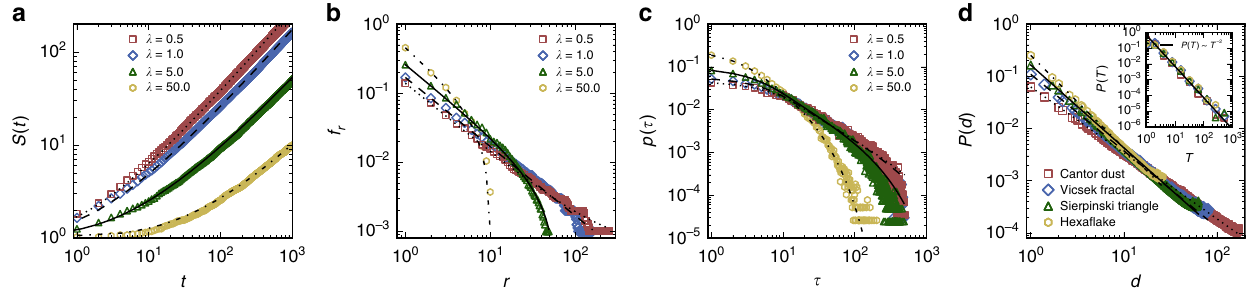
Fig. 6 Analytic predictions of a simpli fi ed model in comparison with simulation results. a – c Analytically predicted results of S ( t ) — the total number of locations visited by time t , f r — frequency distribution of visiting distinct locations, and P ( τ ) — return time distribution. The curves represent the theoretical results for different values of the memory parameter λ , and the data points are simulation results with N = 1000 and L = 1000. d Travel distance distributions P ( d ) for the simpli fi ed model implemented in four classic fractal domains including a 2D Cantor dust, Vicsek fractal, Sierpinski triangle, and hexa fl ake with fractal dimension D = 1.262, 1.465, 1.585, and 1.771, respectively (Supplementary Note 3), where the lines represent the theoretical results for different values of D . The inset indicates the distributions P ( T ) of the number of traveling steps at the population level for the four fractal domains, with the solid line being the analytic prediction of P ( T